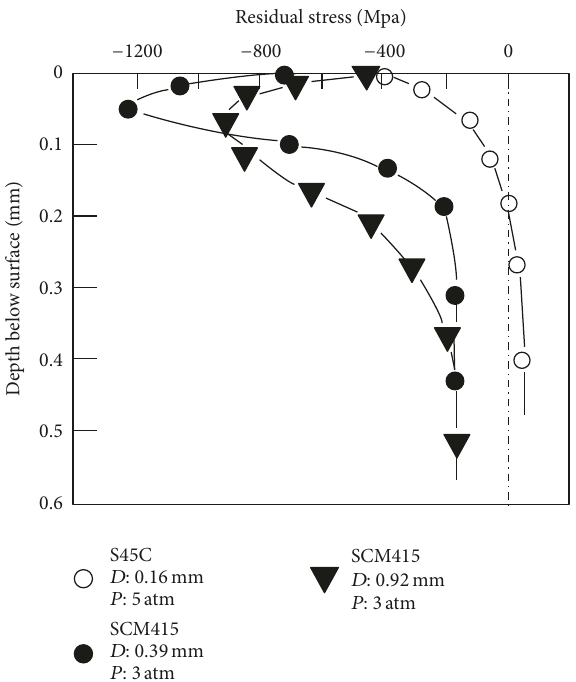
Figure 13: Residual stress distributions induced by shot peening for a medium carbon steel (S45C) and a carburized steel (SCM415) [17].